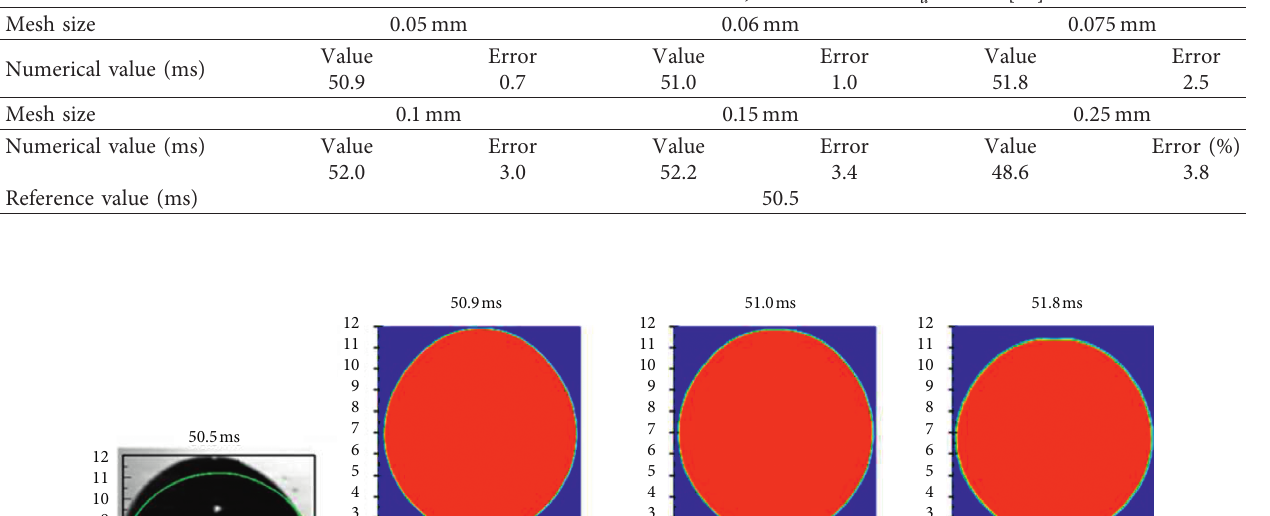
Table 3: Bubble detachment time with different mesh sizes, orifice diameter d